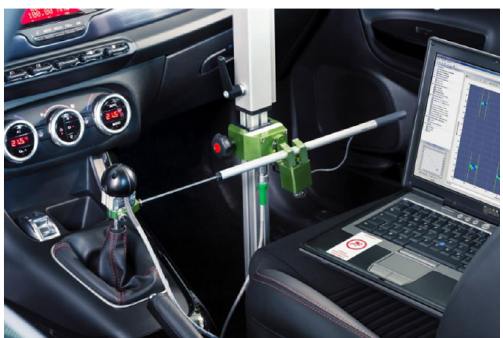
Figure 1. Shift testing system of the whole vehicle.